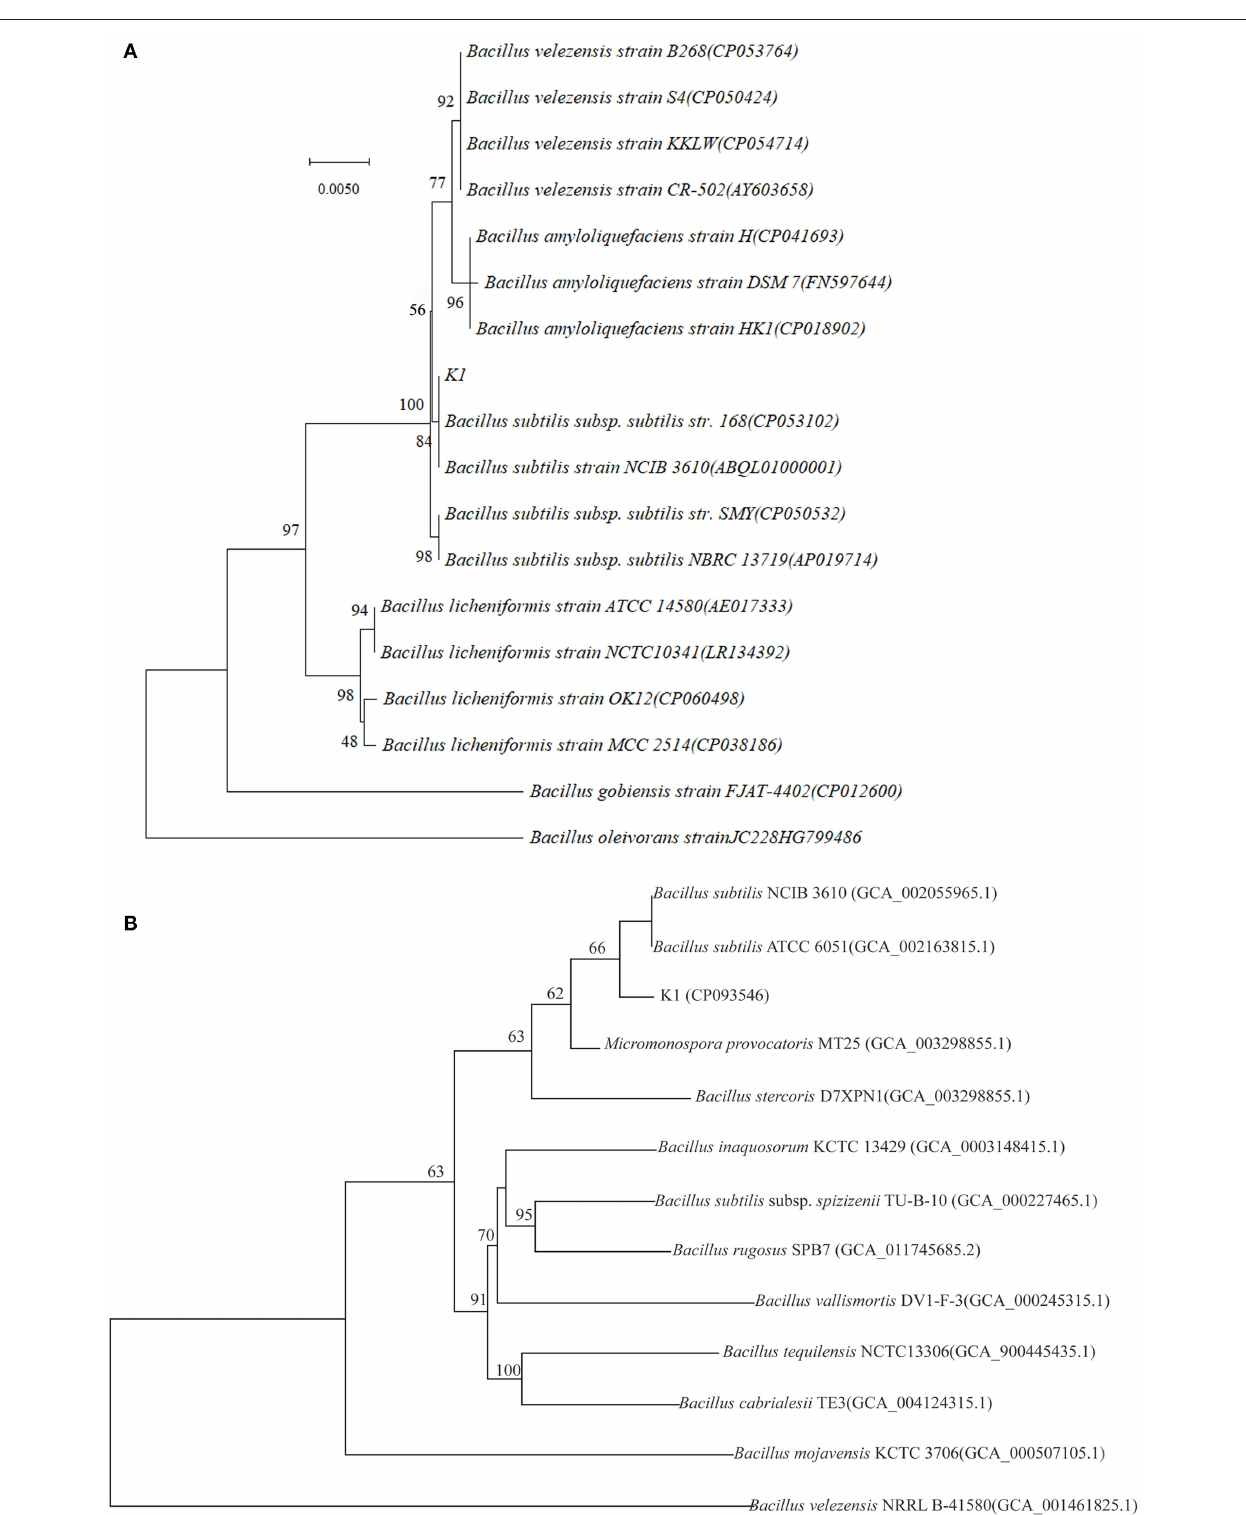
FIGURE 3 | Identification of bacterial strain K1 based on 16S rRNA and Type Strain Genome Server (TYGS). (A) Phylogenetic analysis of K1 based on 16S rRNA sequences. (B) The minimum evolution tree based on the genome sequence of recognized strains from TYGS. The trees were constructed with bootstrap support based on 100 pseudo-bootstrap